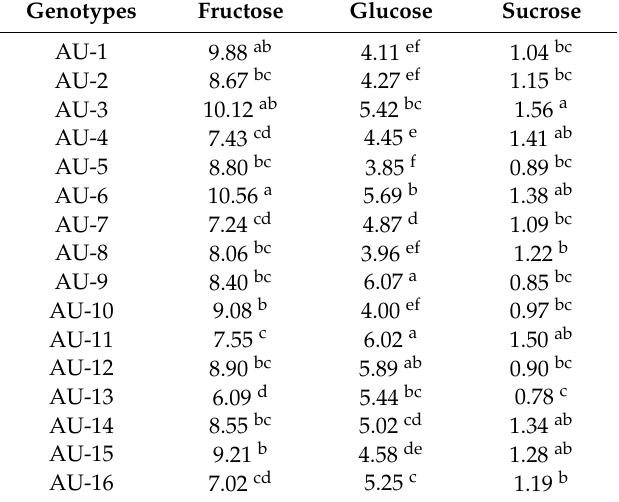
Table 4. Sugar concentration in the fruit of strawberry tree genotypes (average of 2017–2018 years) (g / 100 g FW).